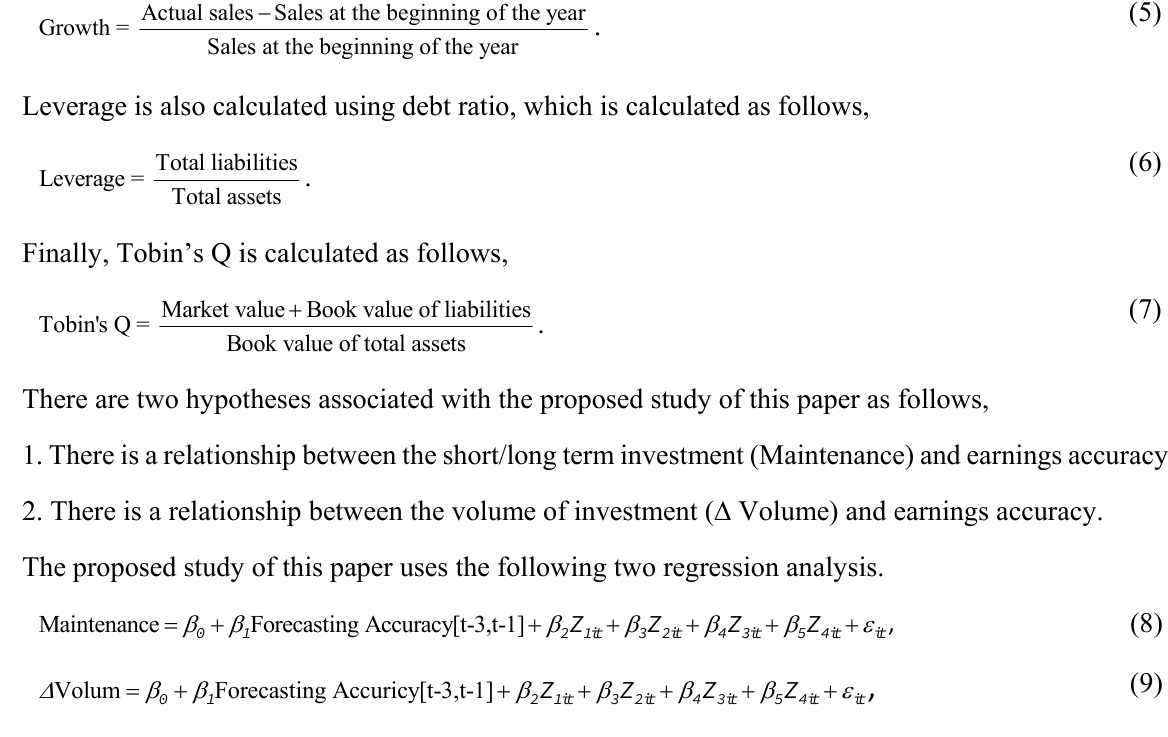
The summary of some basic statistics Variable